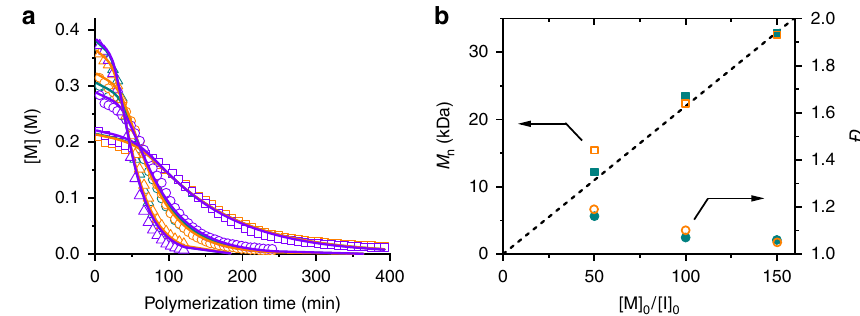
Fig. 5 Kinetic modeling of polymerization of NCA in DCM. a Polymerization kinetics in Fig. 2c were fi t with the adsorption-incorporated kinetic model. b Comparison of experimental results obtained from GPC analysis (solid symbols) and predicted results from modeling (open symbols) with various [M] 0 / [I] 0 ratios at [M] 0 = 0.4 M. The dashed line represents designed MW by [M] 0 /[I] 0